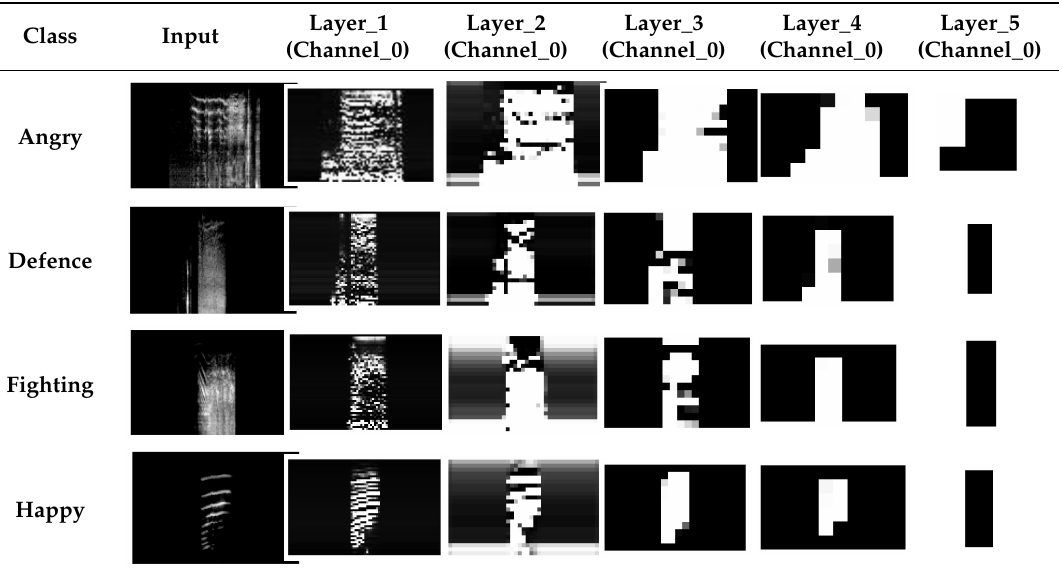
Figure 7. An overview of feature extraction from CDBN network and classification. The features from each layer are extracted using FDAP with overlapping shown in each segmented feature block. Each layer parameters are represented as ( time × frequency × channel ). The concatenated feature vector is fed into various classifiers and voting for the predicted probability of the final ensemble result. Table 1. First channel learned feature visualization of proposed CDBN in each layer. The wave form representation of same sample data is in Figure